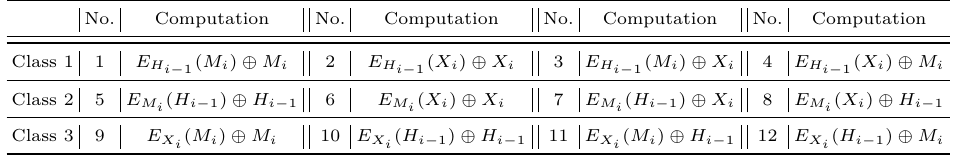
Table 2: Twelve secure PGV constructions [PGV94, Sas11].